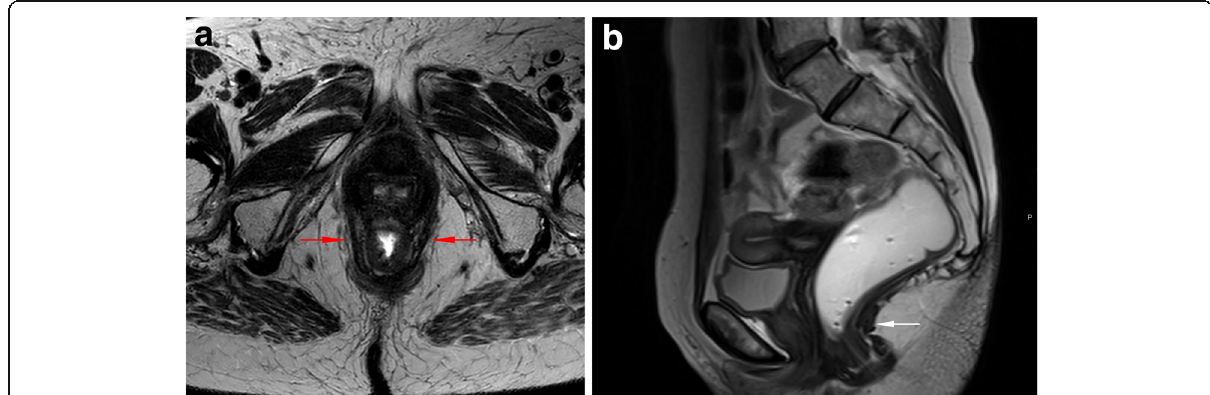
Fig. 6 Anorectal junction (ARJ). ( a, b ) Axial T2-TSE image ( a ) at the plane of the puborectalis muscle (red arrows), the same plane of the ARJ. Sagittal T2-TSE image (b) showing the posterior wall of the ARJ (white